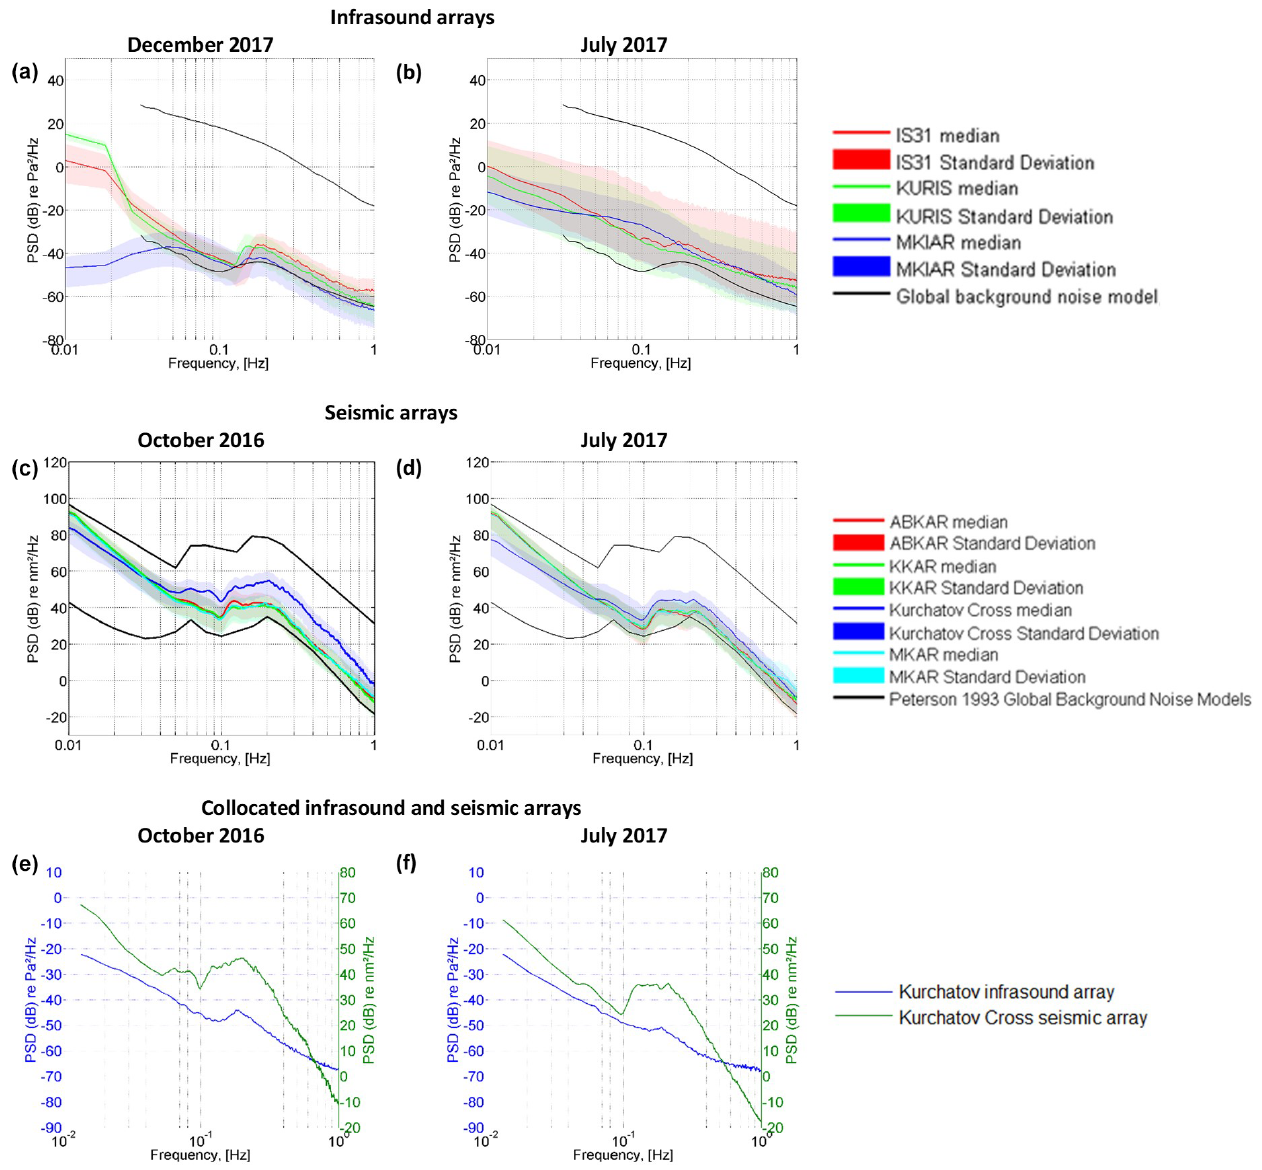
Figure B1. PSD noise spectra at infrasound arrays (a, b) and seismic arrays (c, d) . Comparison of noise spectra at collocated KURIS and Kurchatov Cross